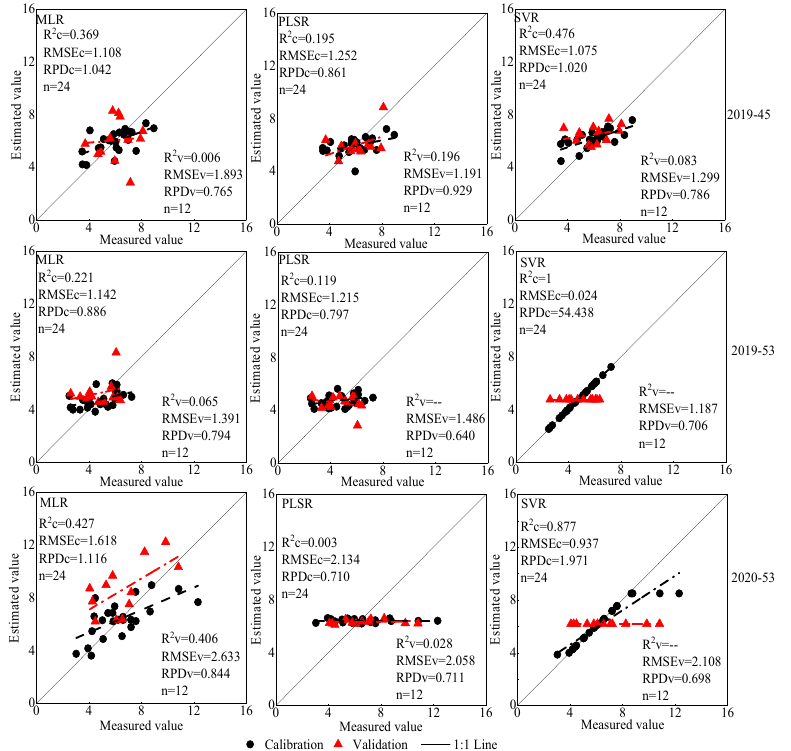
Figure 8. Establishment of the CND estimation model for cotton bud stage under drip irrigation. Compared with the bud stage, the estimation accuracy of canopy nitrogen density in the initial flowering stage of drip-irrigation cotton was not improved (Figure 9), which was consistent with the results for the bud stage. The model established by SVR also had a serious overfitting phenomenon, and the canopy nitrogen density data in 2019-53 also had serious overfitting.